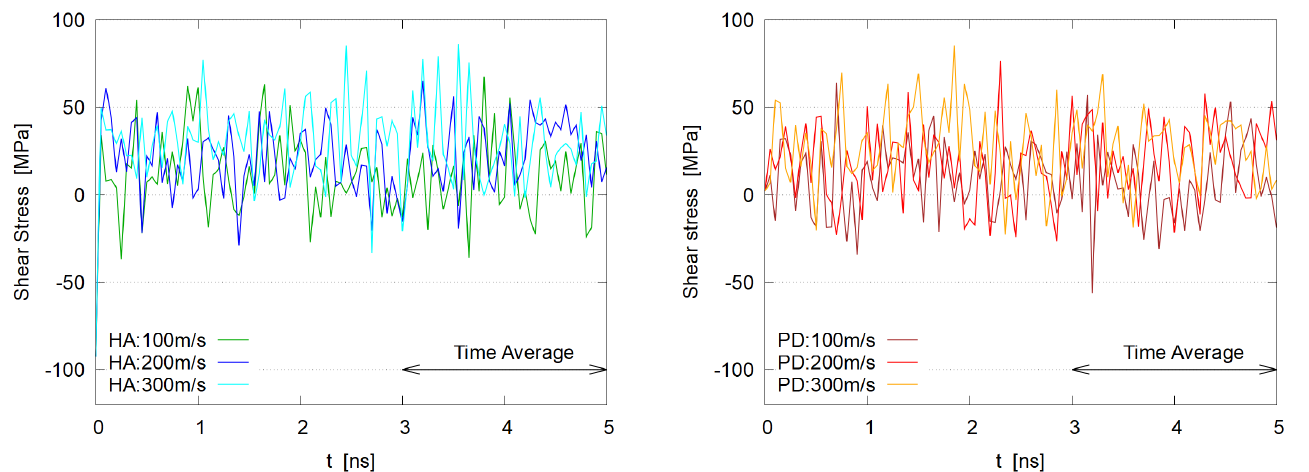
Figure 7. Time evolution of shear stress, − P xz for HA ( left ) and PD ( right ) systems; short period (50ps) time average is taken, similar to Figure